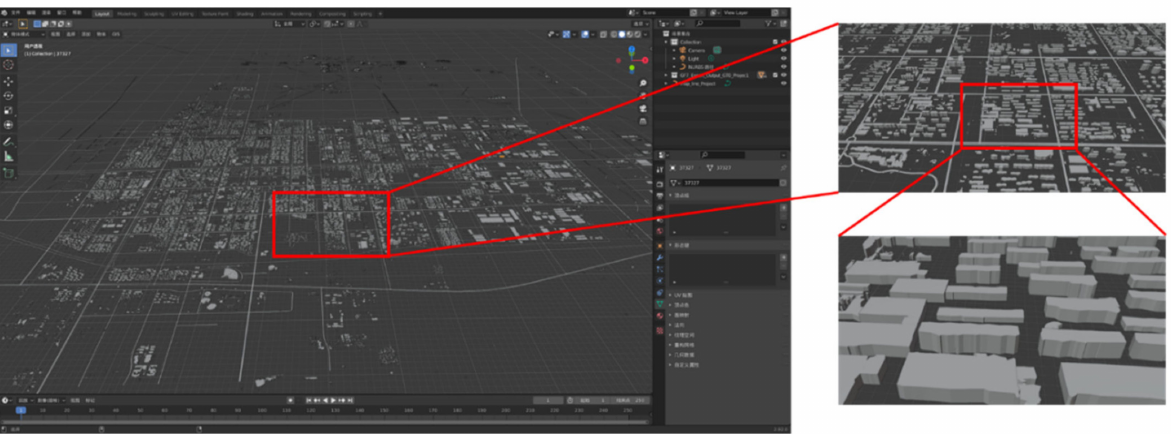
Figure 13. Generation of a building from the polygon of GF-7 building extraction results and DSM